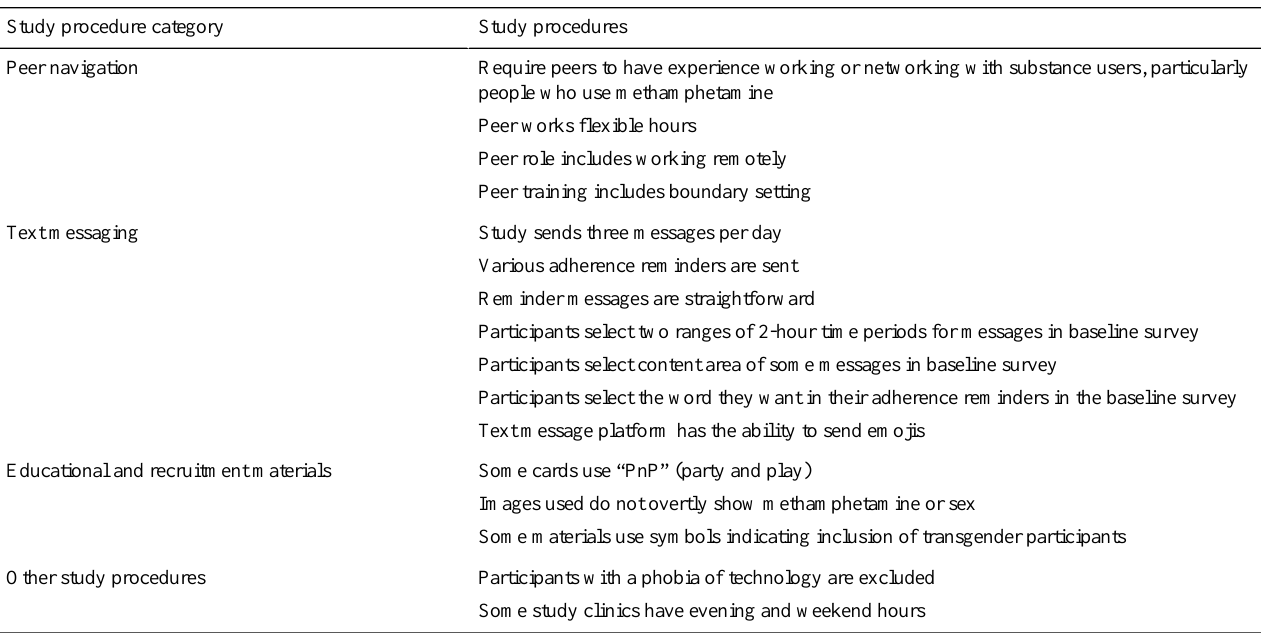
Table 3. Study procedures implemented based on formative research findings.